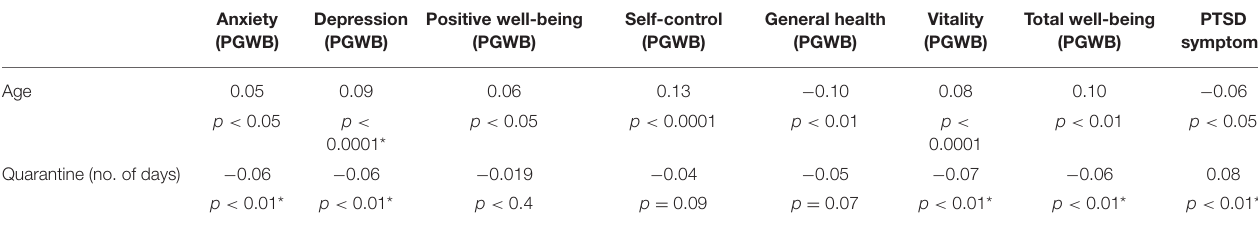
TABLE 6 | Pearson’s r correlations between psychological dimensions of distress, age, and time spent in